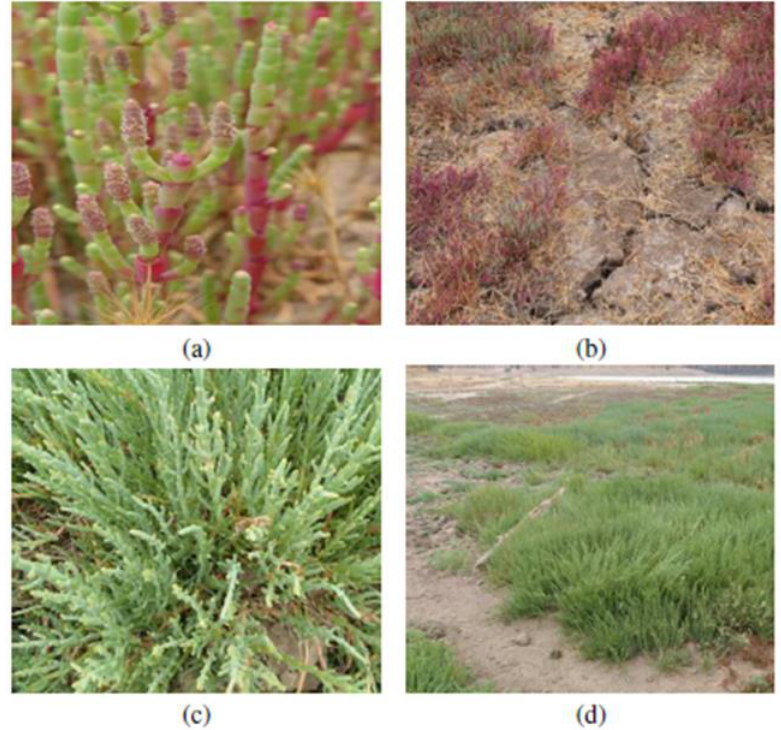
Figure 2. State and morphology of S. neei in Los Maitenes ( a , b ) and Matanzas ( c , d ) coastal wetlands. You can see a difference in color. Note the difference in color of S. neei leaves.